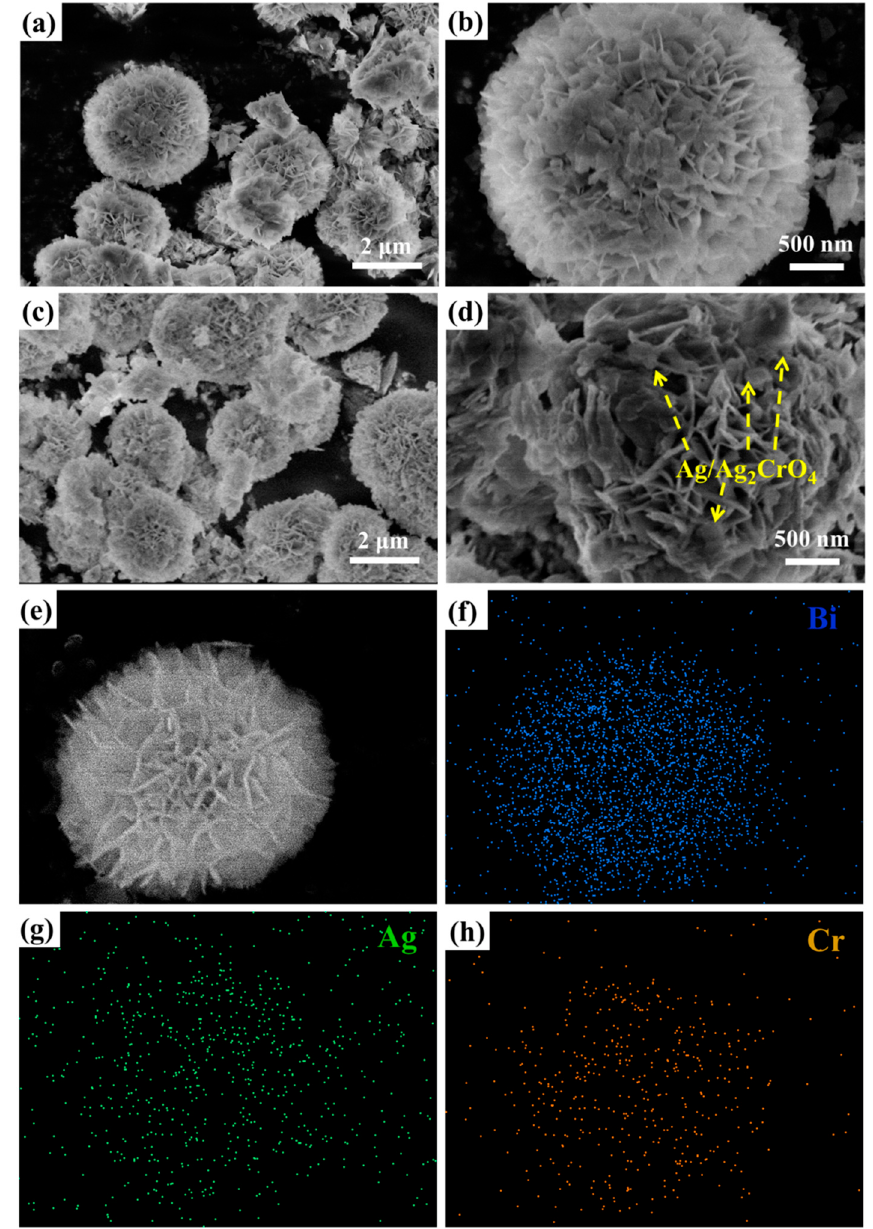
Figure 3. SEM images of bare BiOCOOH ( a , b ) and Ag / Ag 2 CrO 4 / BiOCOOH ( c , d ); EDS elemental mapping of Ag / Ag 2 CrO 4 / BiOCOOH ( e – h ).